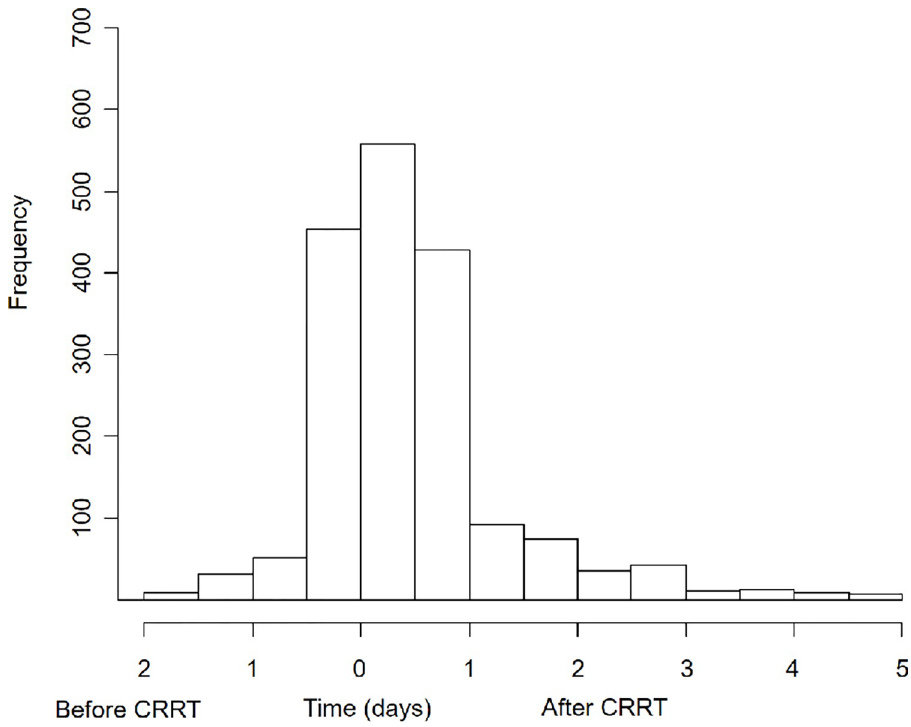
Fig 1. Histogram of patients with nephrology consultation according to consultation time. CRRT, continuous renal replacement therapy.